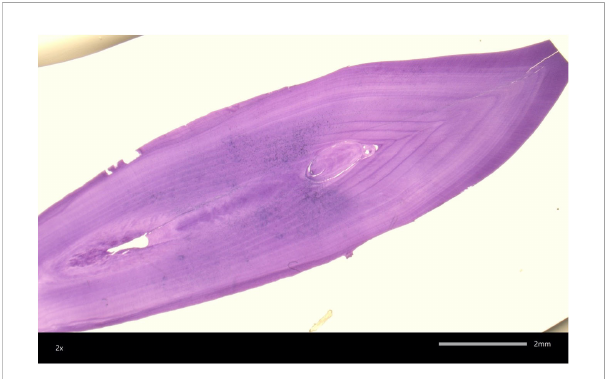
FIGURE 9 Cross section of a bottlenose dolphin tooth showing a “ pulp stone ” within the GLG layers which could interfere with GLG counts. Image courtesy of W.